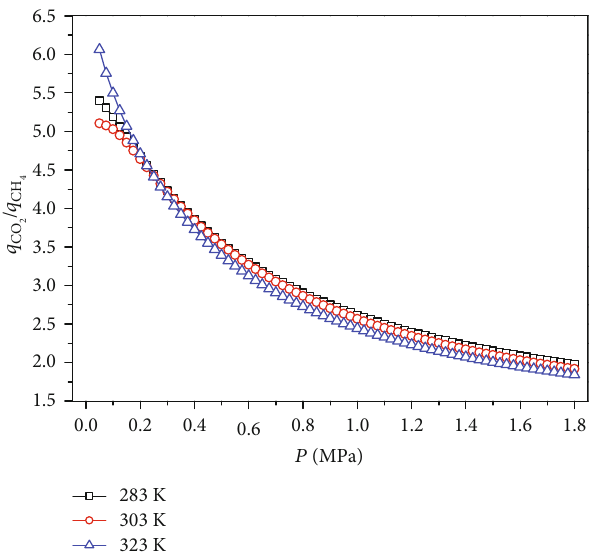
Table 3: Physical and chemical characteristics of CO